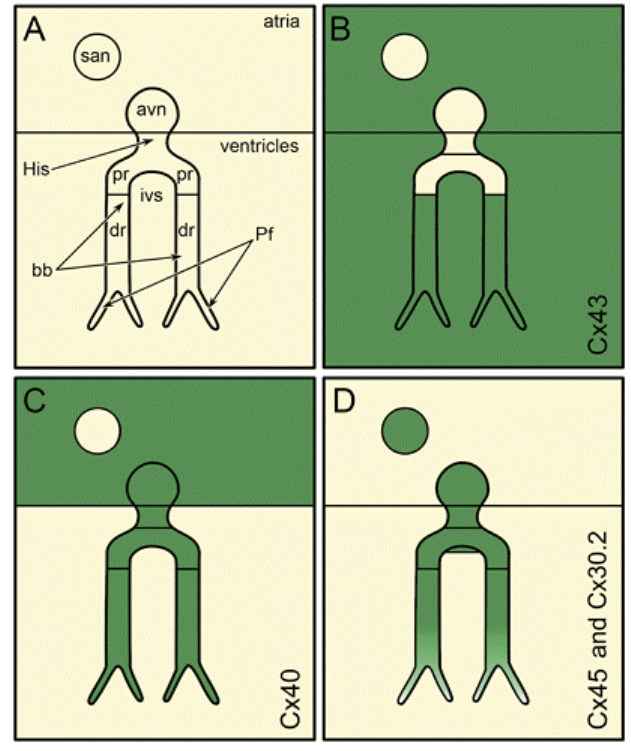
FIGURE 8. Schematic overview of the expression of Cx40, 43, 45, and 30.2 in the adult mouse heart. The expression pattern of Cx30.2 largely colocalizes with expression of Cx45[115]. avn: atrioventricular node, bb: bundle branches, dr: distal part of bundle branch, His: His bundle, ivs: interventricular septum, Pf: Purkinje fibers, pr: proximal part of bundle branch, san: sinoatrial node. Adapted from Miquerol et